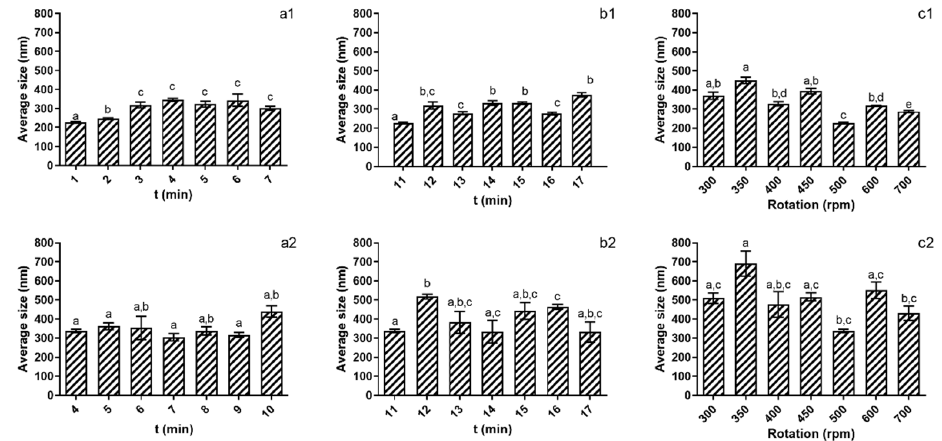
Figure 1. Evaluation of the studied parameters on nanoparticles’ size at pH 5 (1) and pH 4 (2). ( a )—TPP addition time; ( b )—Reaction time; ( c )—rotation speed. Different letters represent the statistical differences found between conditions assayed.